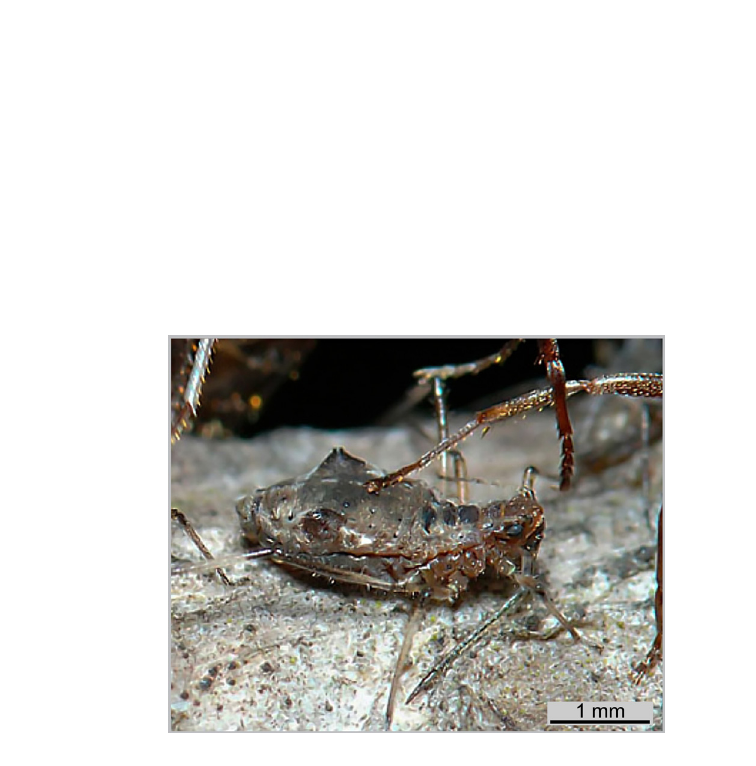
Fig. 90. Cinara (Cinara) acutirostris Hille Ris Lambers, 1956. Aptera on Pinus nigra (from Dransfield & Brightwell 2015, licensed under Creative Commons Attribution 3.0, downloaded 2 Mar. 2016).